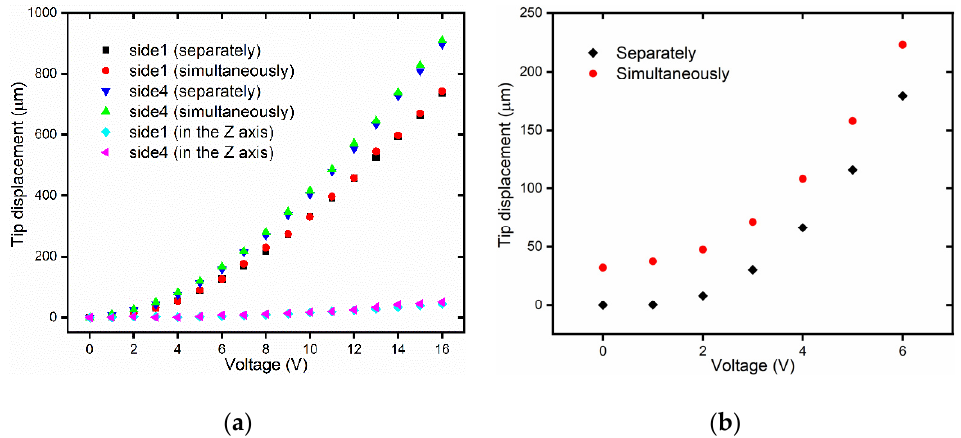
Figure 11. The displacement when V-shaped actuator and 3D U-shaped actuator move simultaneously and separately; ( a ) The displacement of the 3D U-shaped actuator; ( b ) The displacement of the V-shaped actuator.